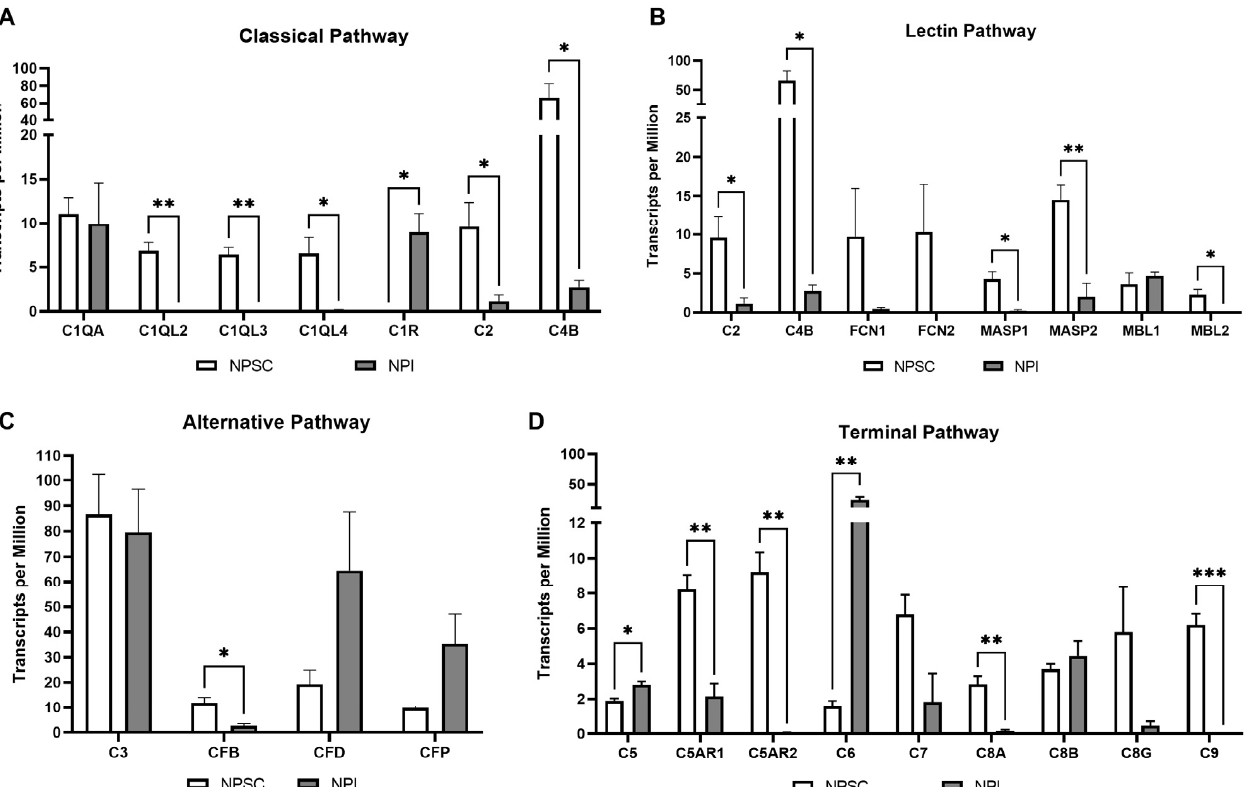
Figure 3. Complement component expression by NPSCs versus NPIs. RNA sequencing of classical pathway ( A ), lectin pathway ( B ), alternative pathway ( C ), and terminal pathway ( D ) complement components expressed by NPSCs (white bars) and NPIs (gray bars). Statistical significance was determined with the unpaired t -test. Note: C3 is included in the alternative pathway but also serves as a convergence point for all three activation pathways as indicated in Figure 1. * p ≤ 0.05. ** p ≤ 0.01. *** p ≤ 0.001.